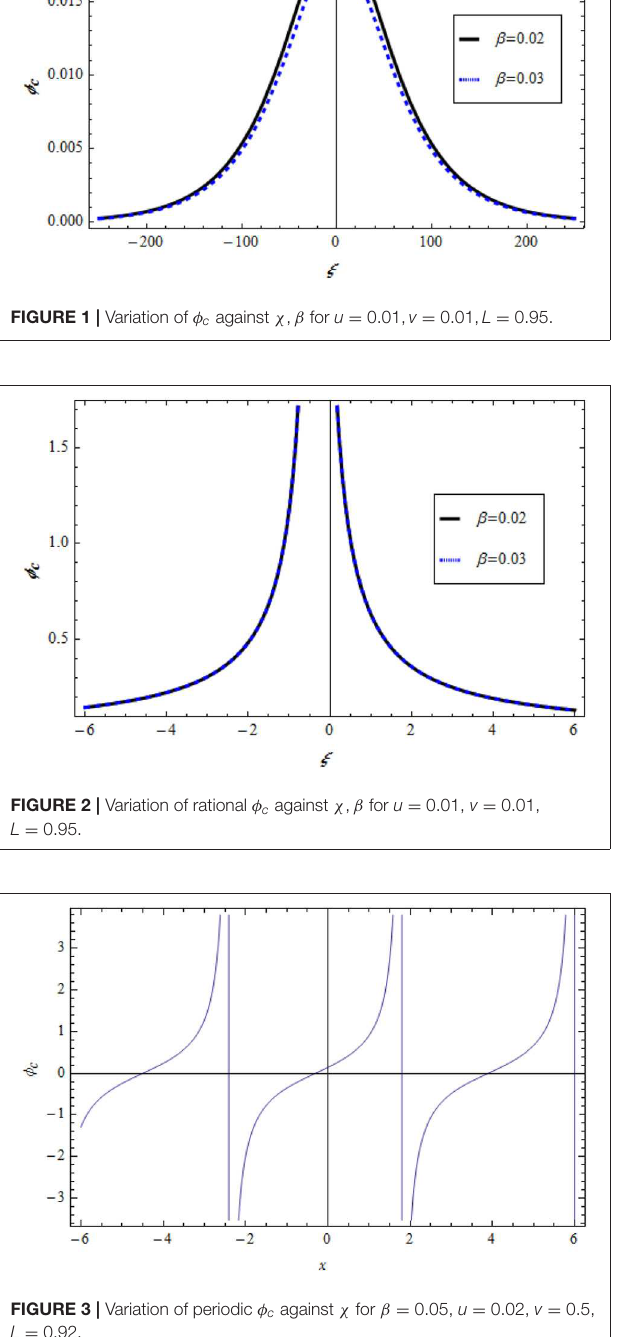
0.05, u 0.02, v 0.5, = = =